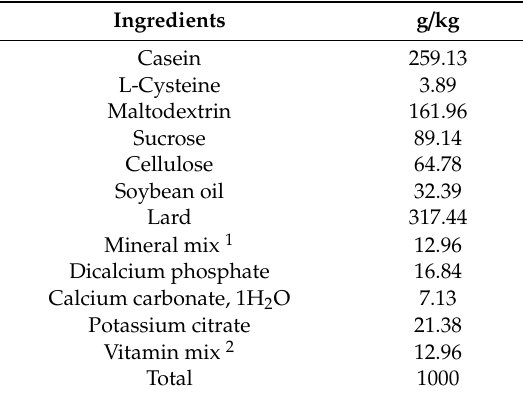
Table 1. Compositions of the high-fat